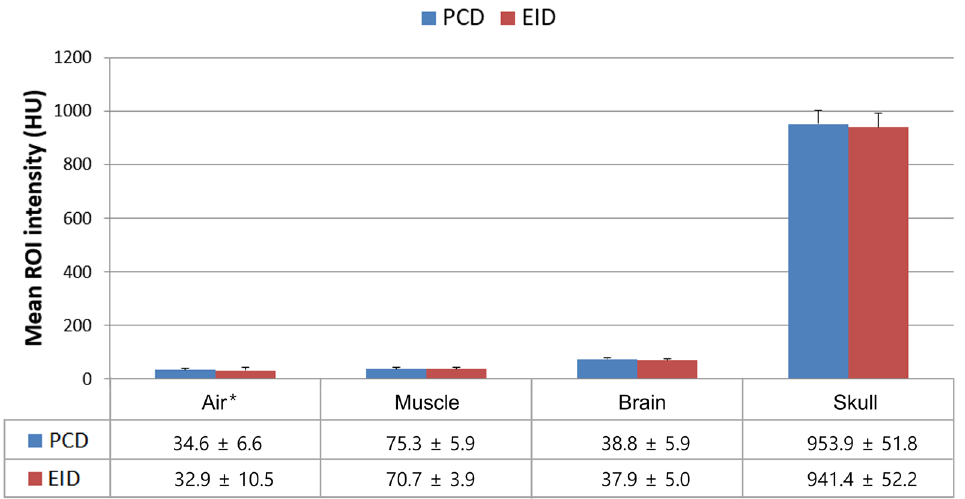
Figure 9. Mean HU values of air, muscle, brain, and skull image acquired from PCD and EID in Fig. 5. *The mean HU unit values for air were added to the value of 1000 HU for easier